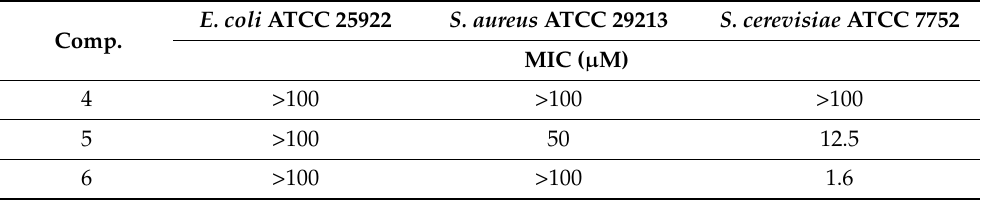
Table 3. Antibacterial activity of prepared 2,5-disubstituted furanes.